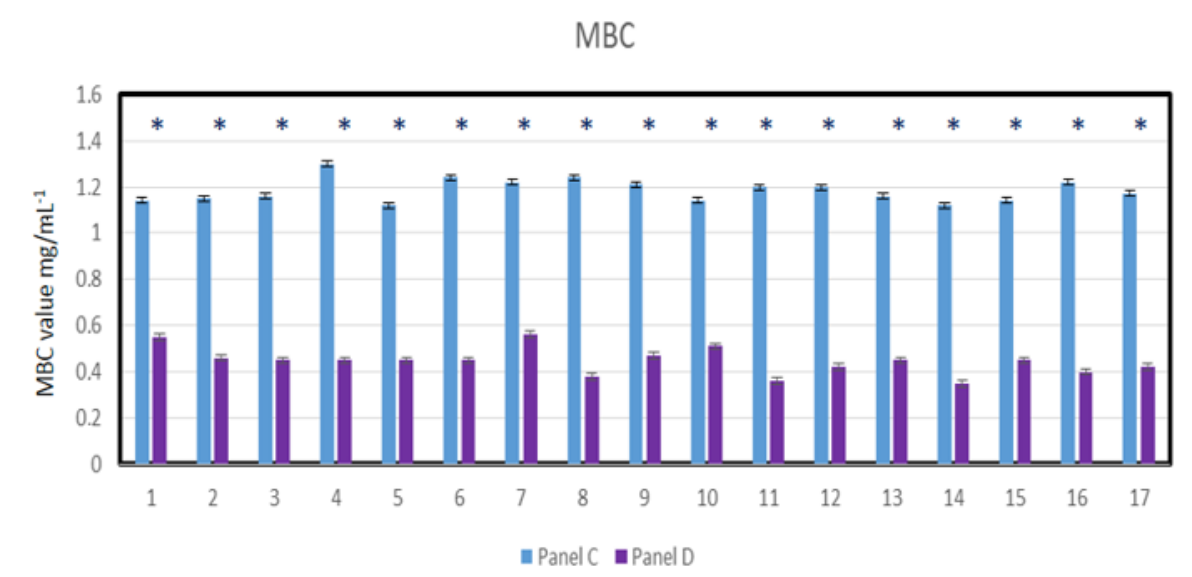
Figure 10. Virus particle analysis using MIC test (panel A- infected volunteers with SARS-CoV-2) and (panel B- infected volunteers after treatment of Salistat SGL03). Statistical significance vs. control in all analyzed samples were at * p < 0.05. X-axis number of study participants from 1 to 17.